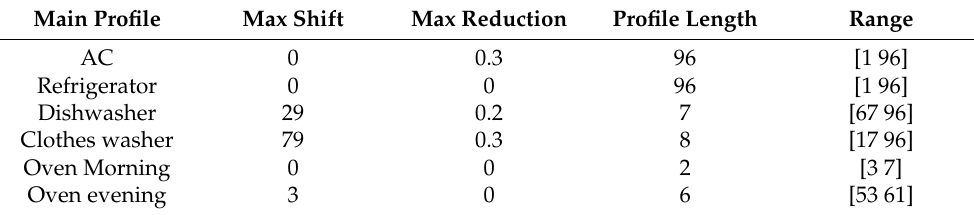
Table 3. Starting and ending times for mixed time range schedule.